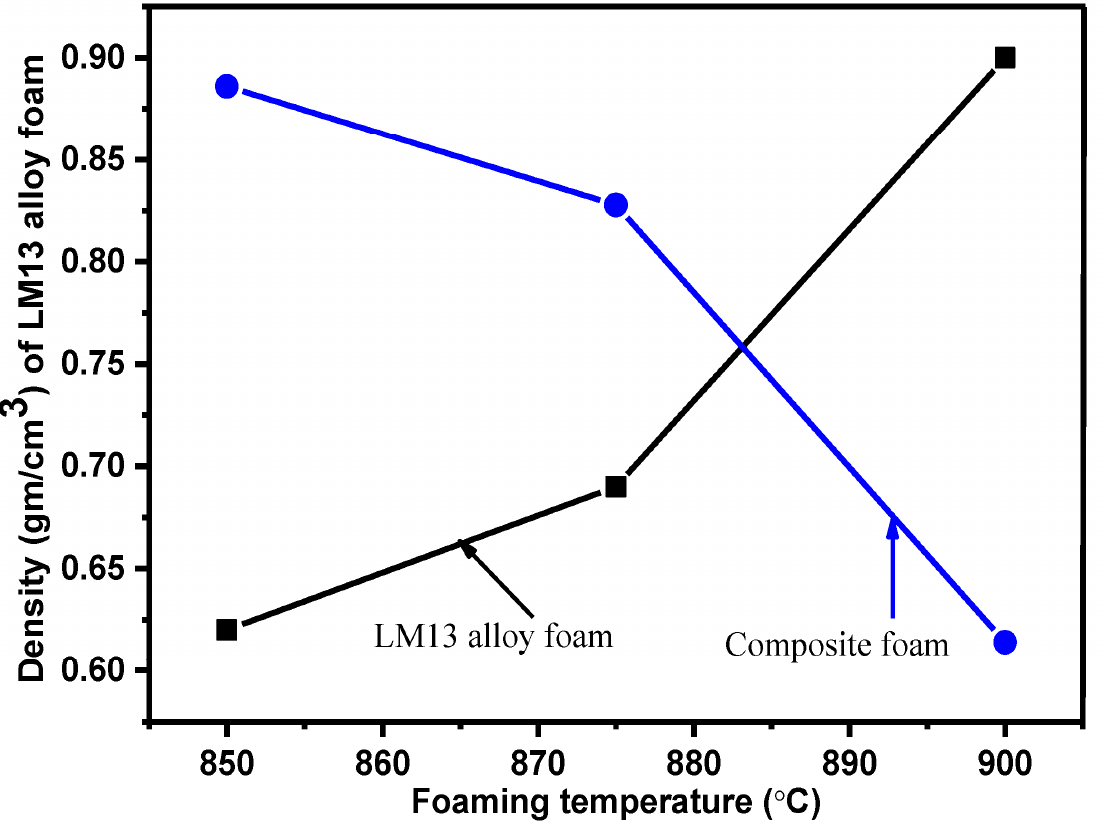
Figure 10. The e ff ect of foaming temperature on the density of LM13 alloy and composite foam. Figure 10. The effect of foaming temperature on the density of LM13 alloy and composite